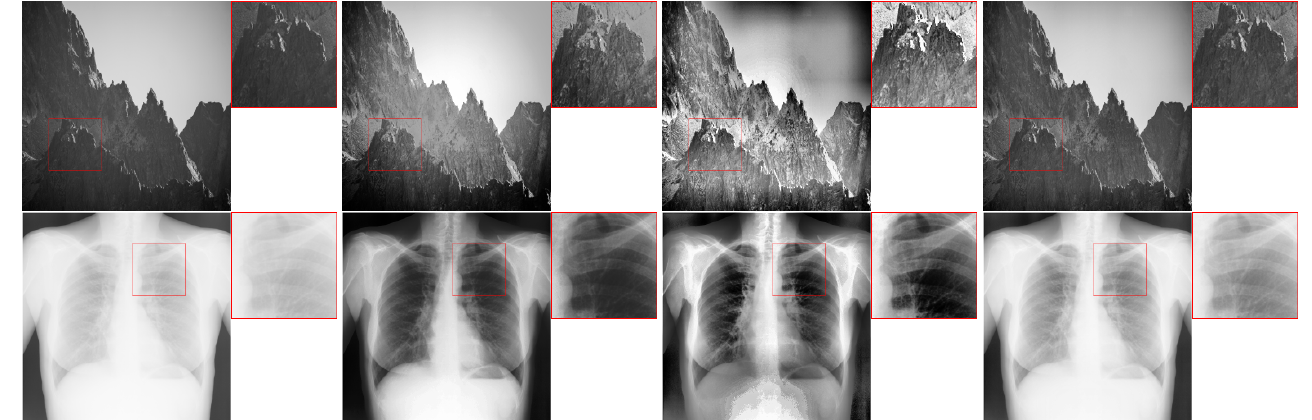
Figure 1. Comparison of Global Histogram Equalization (GHE), Adaptive Histogram Equalization (AHE) and Contrast Limited Adaptive Histogram Equalization (CLAHE). The figures show succes- sively (from the left) the original image, the image after applying GHE, AHE, and CLAHE algorithms. The GHE algorithm does not perform well when there is a significant difference between the highest and the lowest intensity in the image. The main drawback of the AHE is visible in the homogeneous regions (like sky in the mountains image). The CLAHE algorithm performs well in both